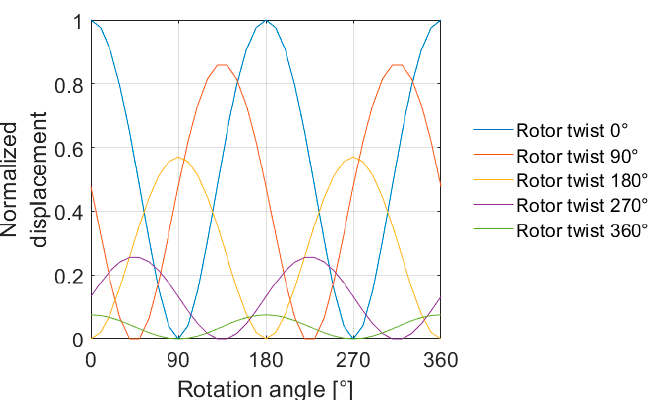
Figure 13. Normalized middle cross-section center point displacement of the rotor as a function of the rotational angle.